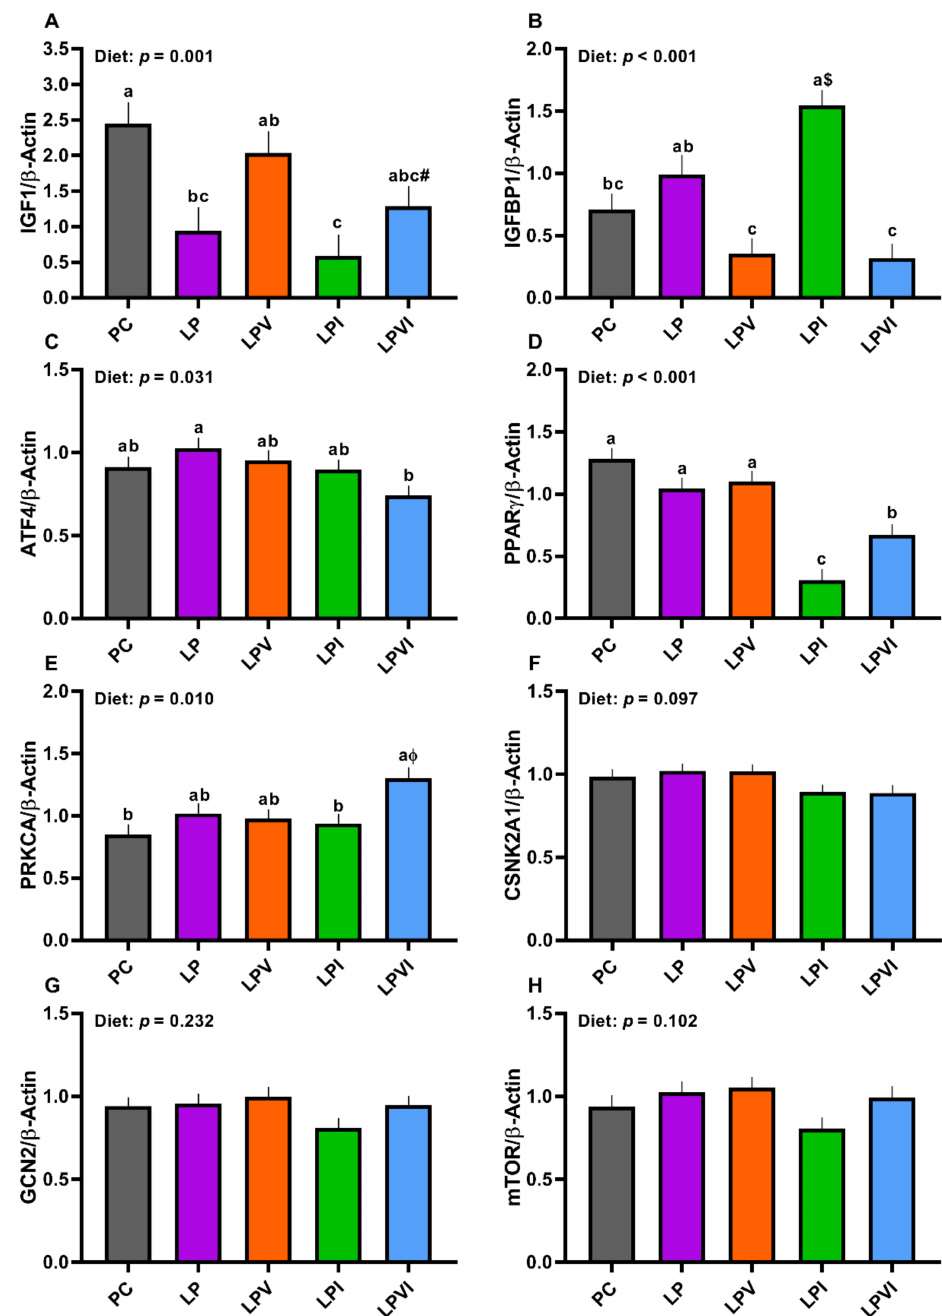
Figure 6. Hepatic mRNA abundance of ( A ) insulin-like growth factor-1 ( IGF1 ), ( B ) insulin-like growth factor binding protein 1 ( IGFBP1 ), ( C ) activating transcription factor 4 ( ATF4 ), ( D ) peroxisome proliferator-activated receptor gamma ( PPAR γ ), ( E ) protein kinase C alpha ( PRKCA ), ( F ) casein kinase 2 alpha 1 ( CSNK2A1 ), ( G ) general control non-derepressible-2 ( GCN2 ), and ( H ) mechanistic target of rapamycin ( mTOR ), in nursery pigs fed with very-low-protein diets supplemented with Ile, Val, or combination of both. PC (positive control): standard-protein diet; LP (negative control): low-protein diet containing limiting amino acids (i.e., Lys, Met, Thr and Trp) at NRC (2012) levels; LPV: LP containing Val at NRC level; LPI: LP containing Ile at NRC level; LPVI: LP containing Val and Ile at NRC levels. The values are means ± standard error of the mean. n = 8. a,b,c Among groups, the means with different superscript letter(s) are different ( p ≤ 0.05). # p ≤ 0.1 LPVI vs. PC, φ p ≤ 0.1 LPVI vs. LPV, $ p ≤ 0.1 LPI vs.